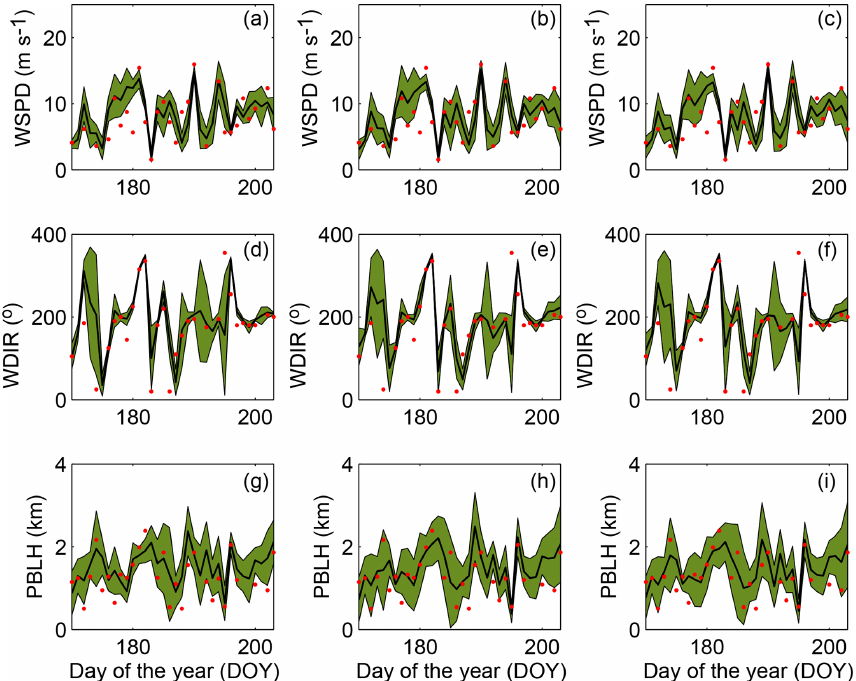
Figure 10. Time series of simulated and observed 300m wind speed (a–c) , 300m wind direction (d–f) and PBLH (g–i) using the 5-, 8- and 10-member calibrated ensembles (first, second and third columns, respectively) at the TOP rawinsonde site. The green shaded area represents the spread (i.e., root mean square deviation) of the ensemble, the black line is the mean of the ensemble, and the red dots are the observations at 00:00UTC.